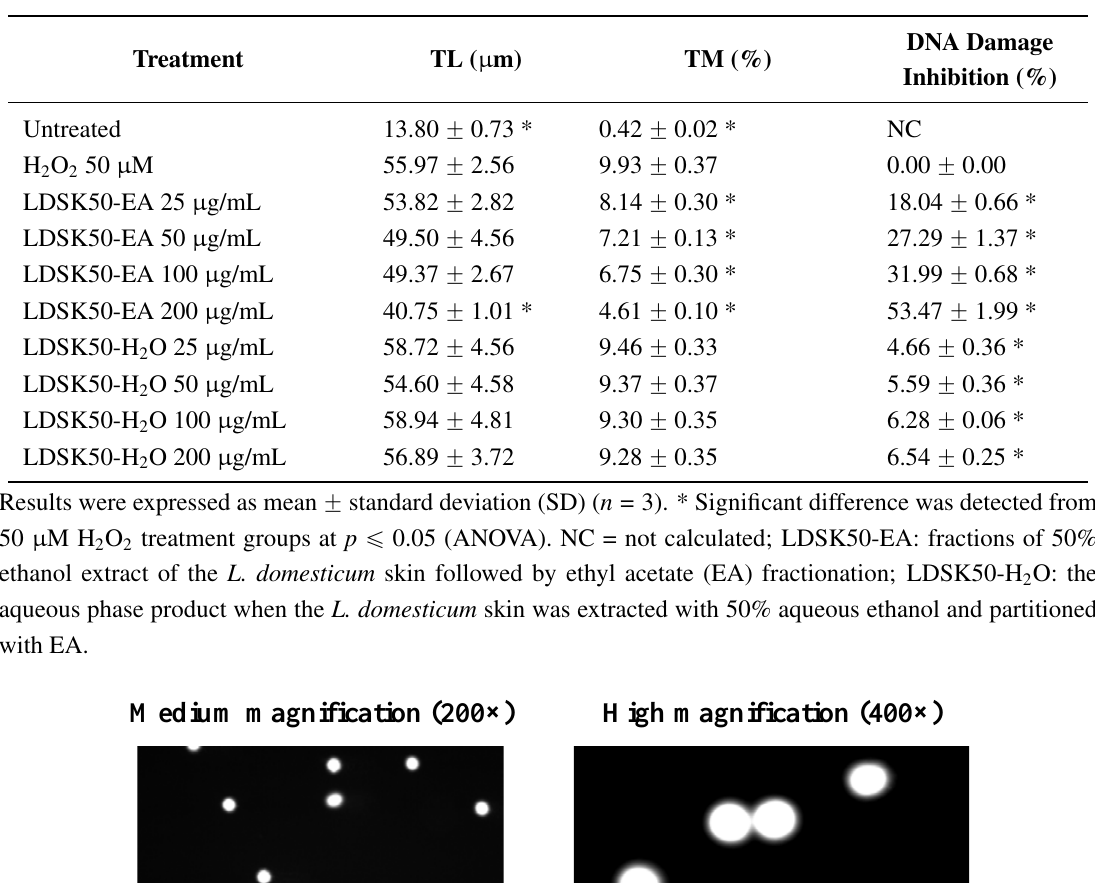
Table 5. DNA damage parameters including tail length (TL) and tail moment (TM) and % inhibitory effect on DNA damage of LDSK50-EA and LDSK50-H 2 O in TK6 cells by comet assay.